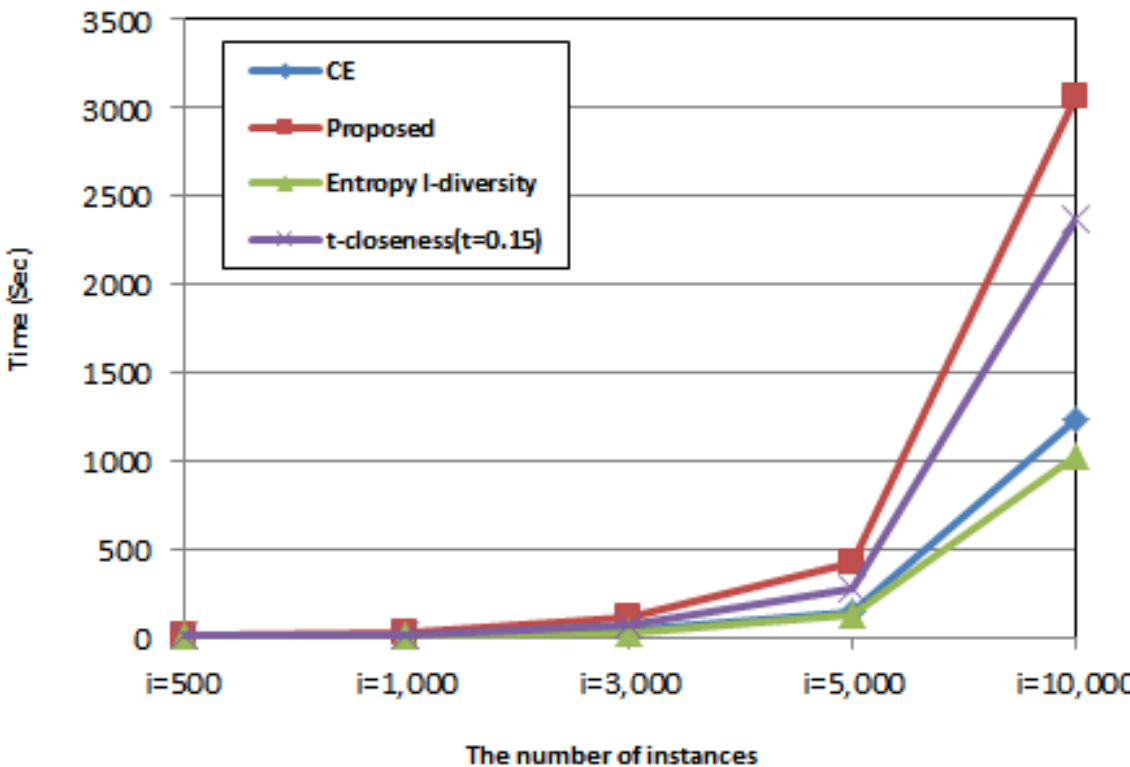
Figure 6. Comparison of execution time with respect to the number of